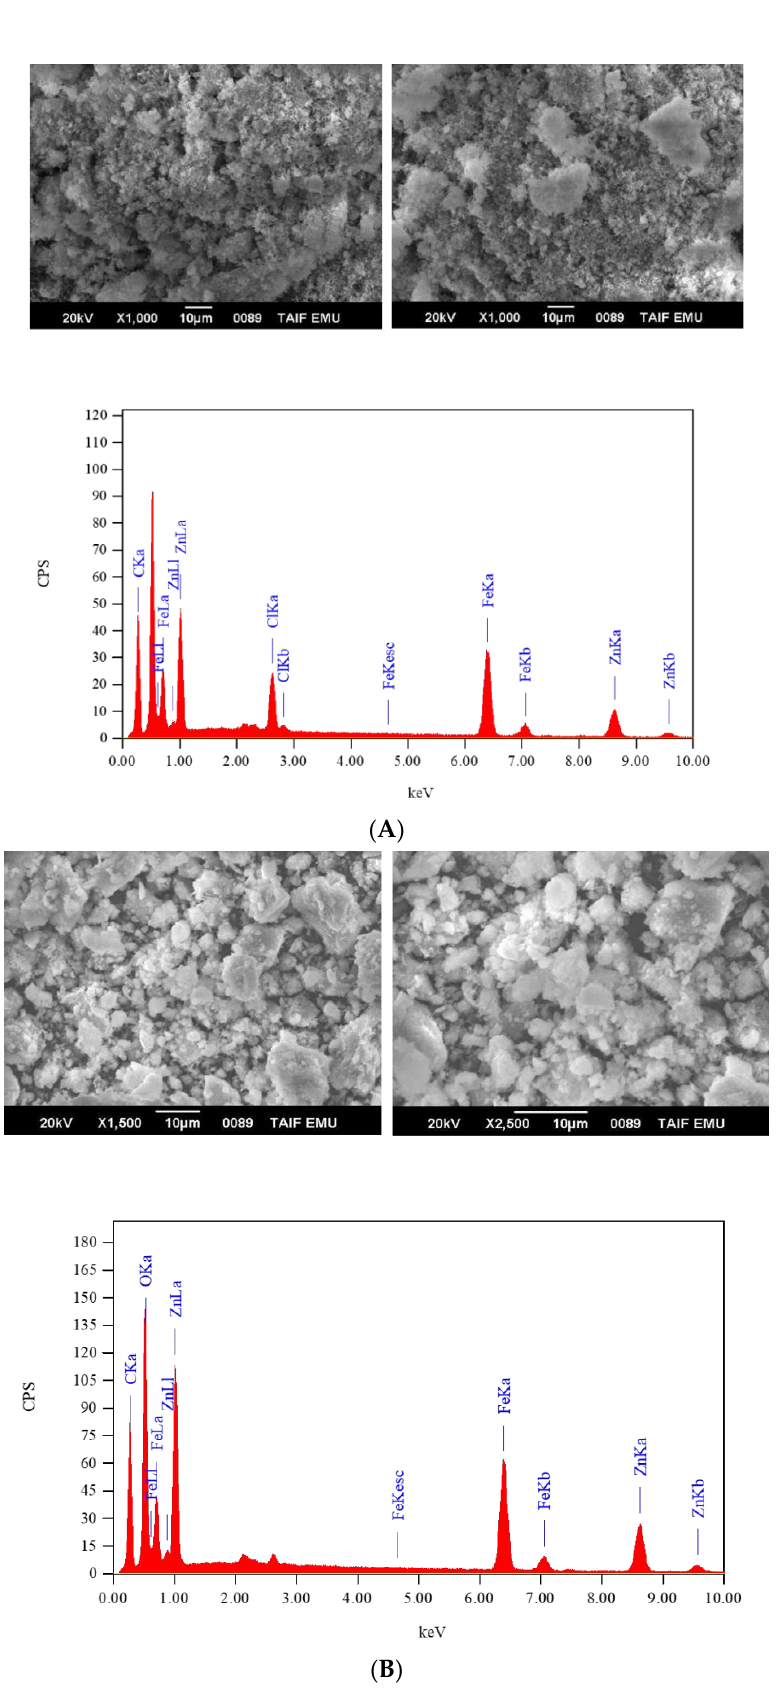
Figure 2. ( A ) SEM images and EDX spectra of solid mixtures: (Zn(NH 2 CONH 2 ) 6 )Cl 2 and (Fe(NH 2 CONH 2 ) 6 )Cl 3 ; ( B ) Zn(NH 2 CONH 2 ) 6 )(CH 3 COO) 2 and (Fe(NH 2 CONH 2 ) 6 )Cl 3 .